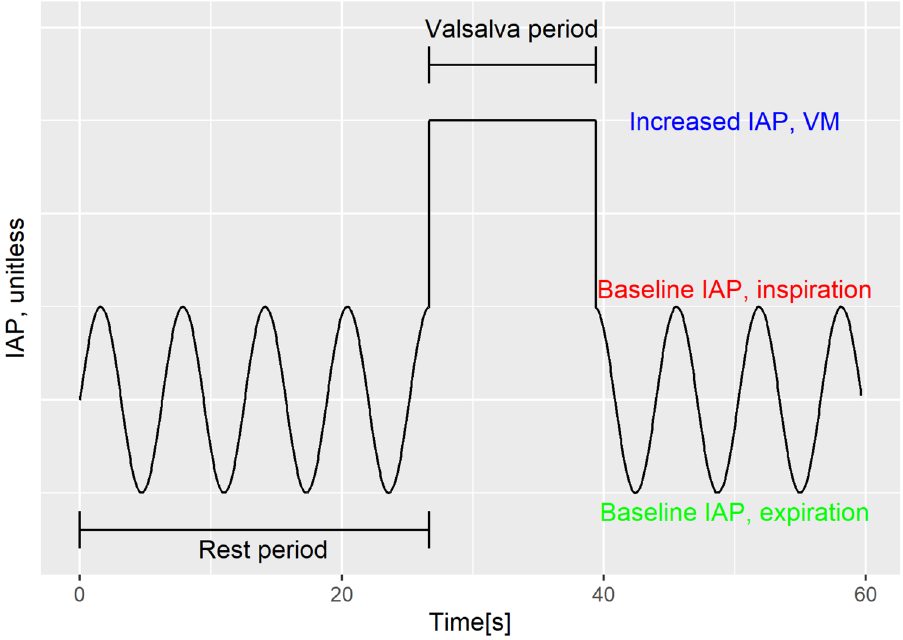
Figure 2. Ideal expected signal of a single MC sensor with an indication of how the rest and Valsalva periods are defined based on end-expiratory phases before and after the Valsalva manoeuvres.